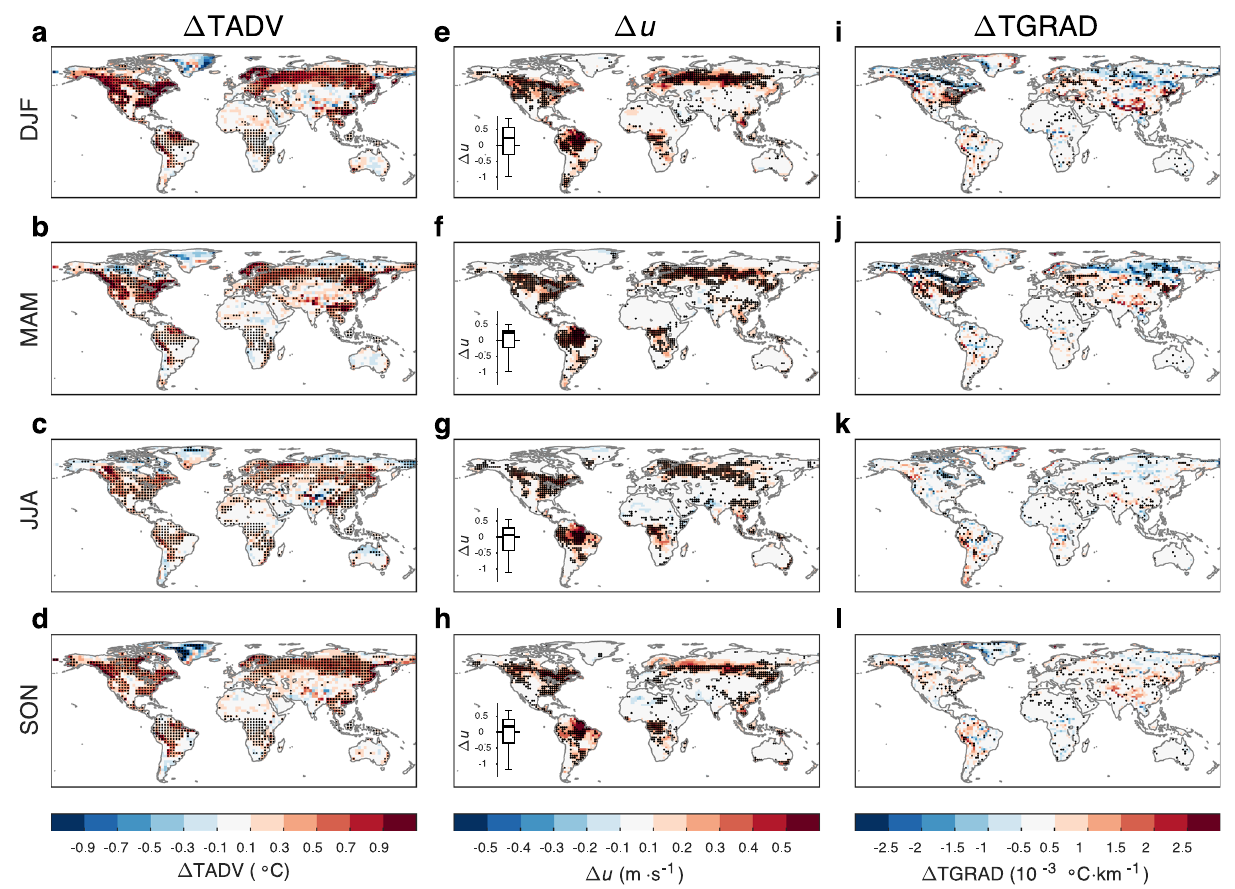
Fig. 3 | The deforestation effect on near-surface horizontal temperature advection and its components. The differences in near-surface horizontal tem- peratureadvection( Δ TADV),windspeed( Δ u ),andthemagnitudeofthehorizontal temperature gradient ( Δ TGRAD) in a , e , i DJF (December, January and February), b , f , j MAM(March,AprilandMay), c , g , k JJA(June,JulyandAugust),and d , h , l SON (September, October and November) between the piControl and deforest-globe simulations (deforest-globe minuspiControl). Δ TADV isfrom the CanESM5model, and the black dots in a – d indicate that Δ TADV is statistically signi fi cant at the 95%